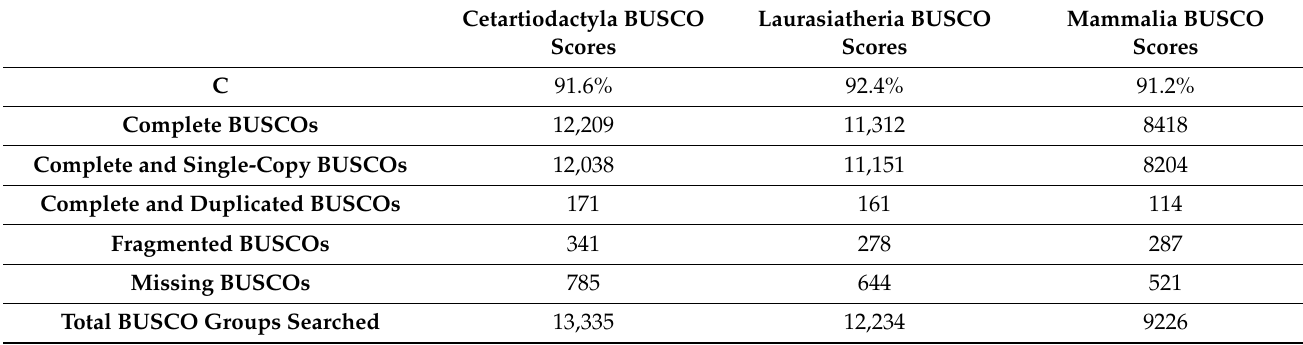
Table 4. BUSCO v5.1.3 scores for the addax in silico mate pair assembly using three different BUSCO lineage